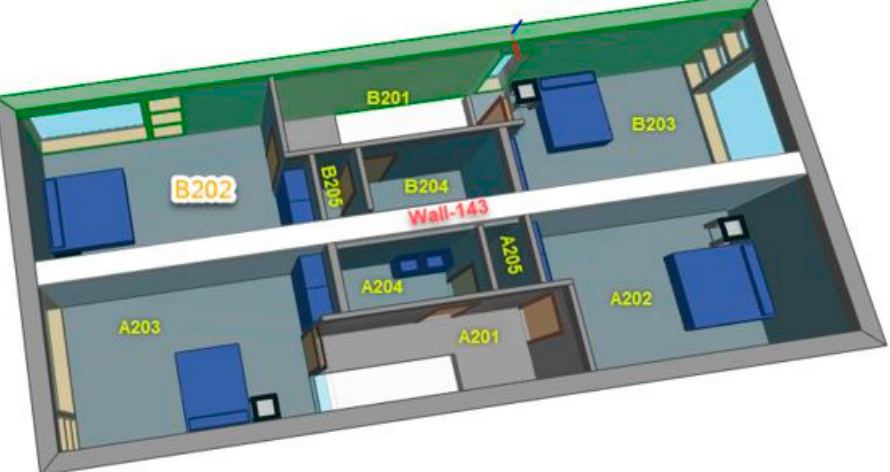
Figure 3. The IFC model (LOD04) includes space and wall objects.